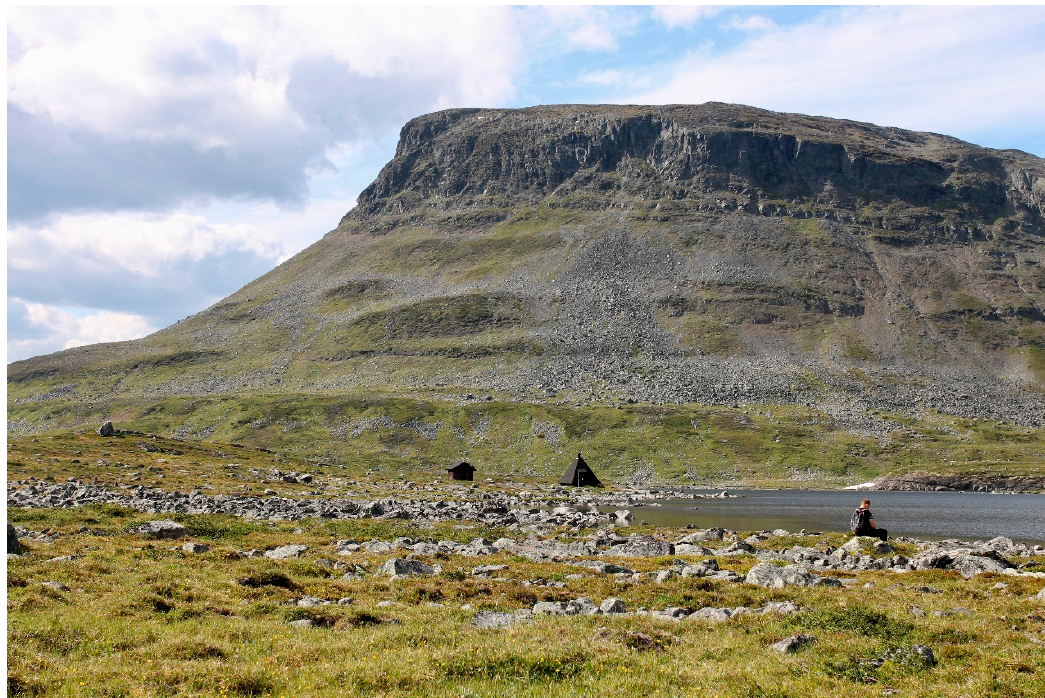
Figure 2. View from the south of Lake Saana to Mount Saana.